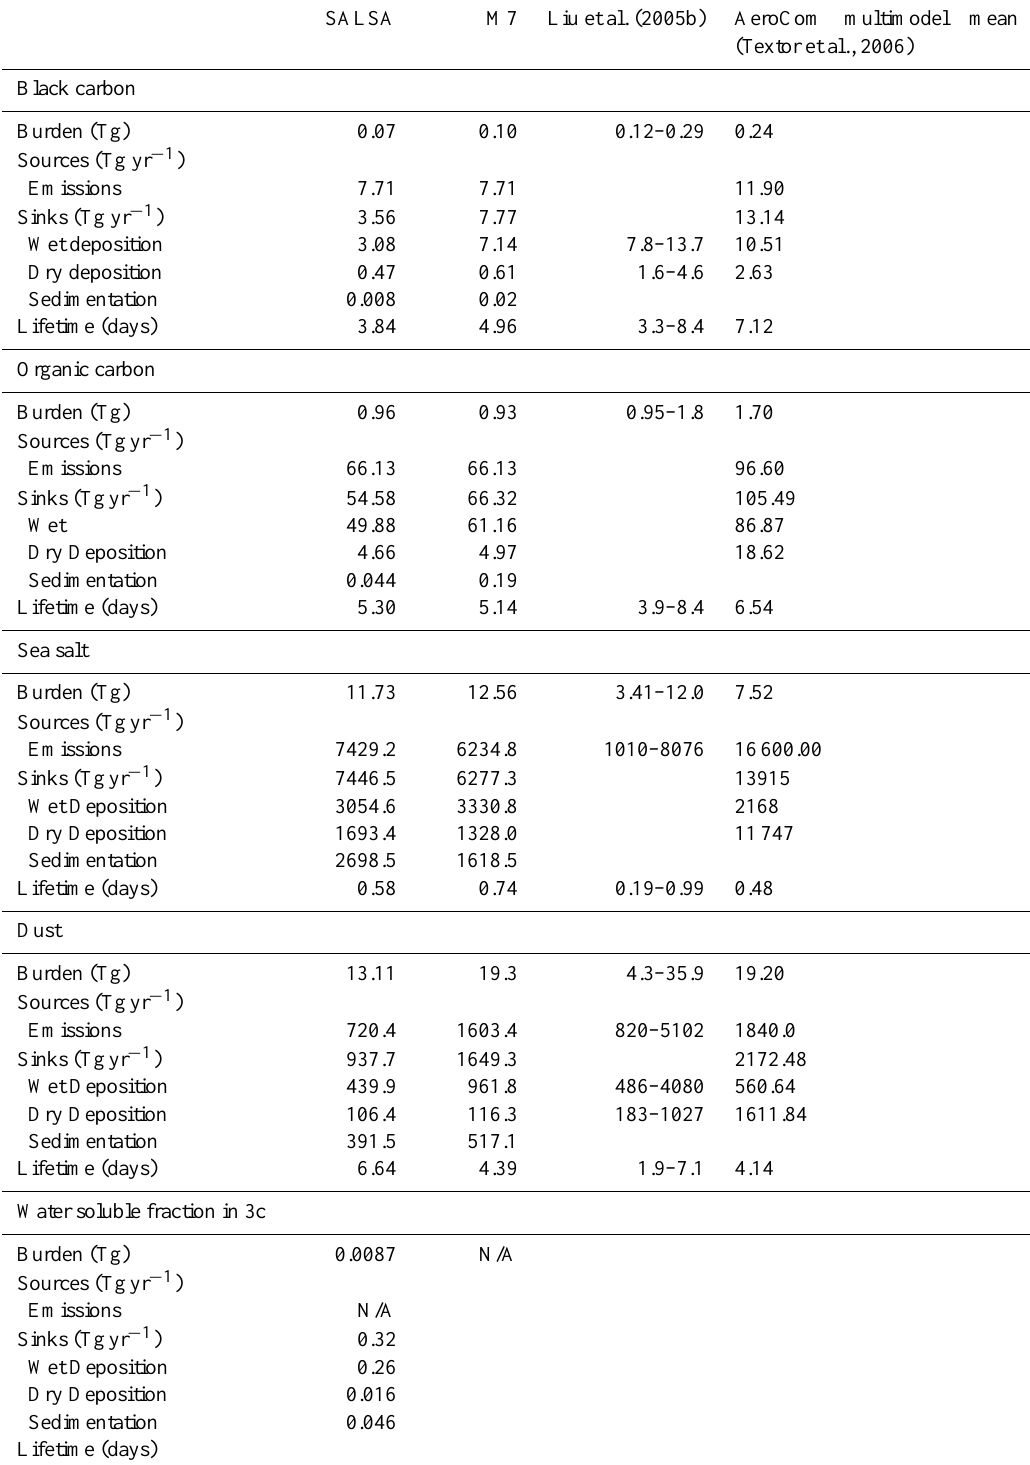
Table 7. Annual mean global black carbon, organic carbon, sea salt and dust budgets calculated using SALSA and M7 together with budgets found in the literature. For Liu and AeroCom, sedimentation is included in dry deposition. SALSA M7 Liu et al. (2005b) AeroCom multimodel mean (Textor et al.,